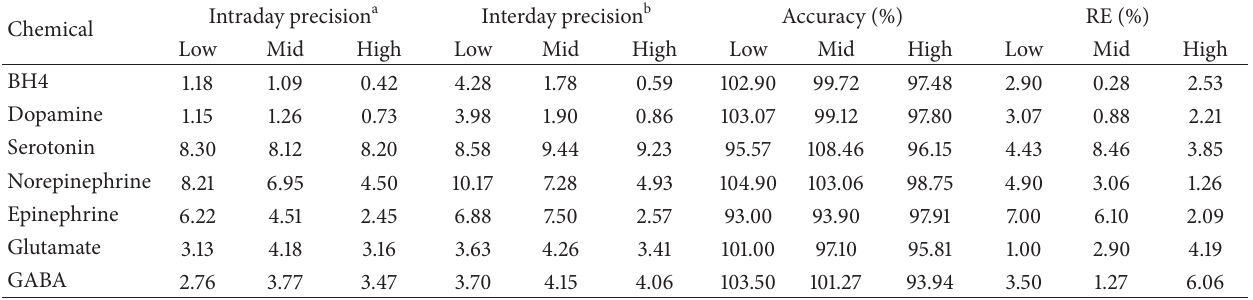
Table 2: Determination of neurotransmitters by LC-MS/MS: validation results on precision and accuracy. Intraday precision a Interday precision b Accuracy (%) Chemical